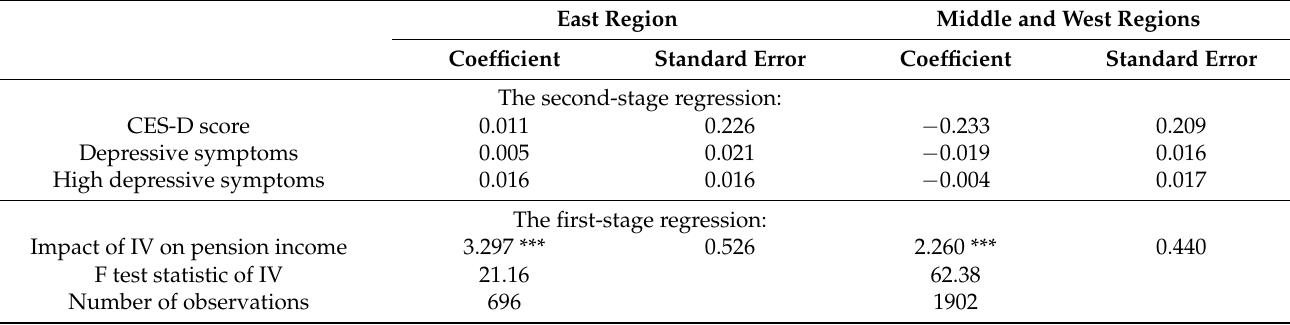
Table 6. Impact of the NRSPI pensions on mental health outcomes by